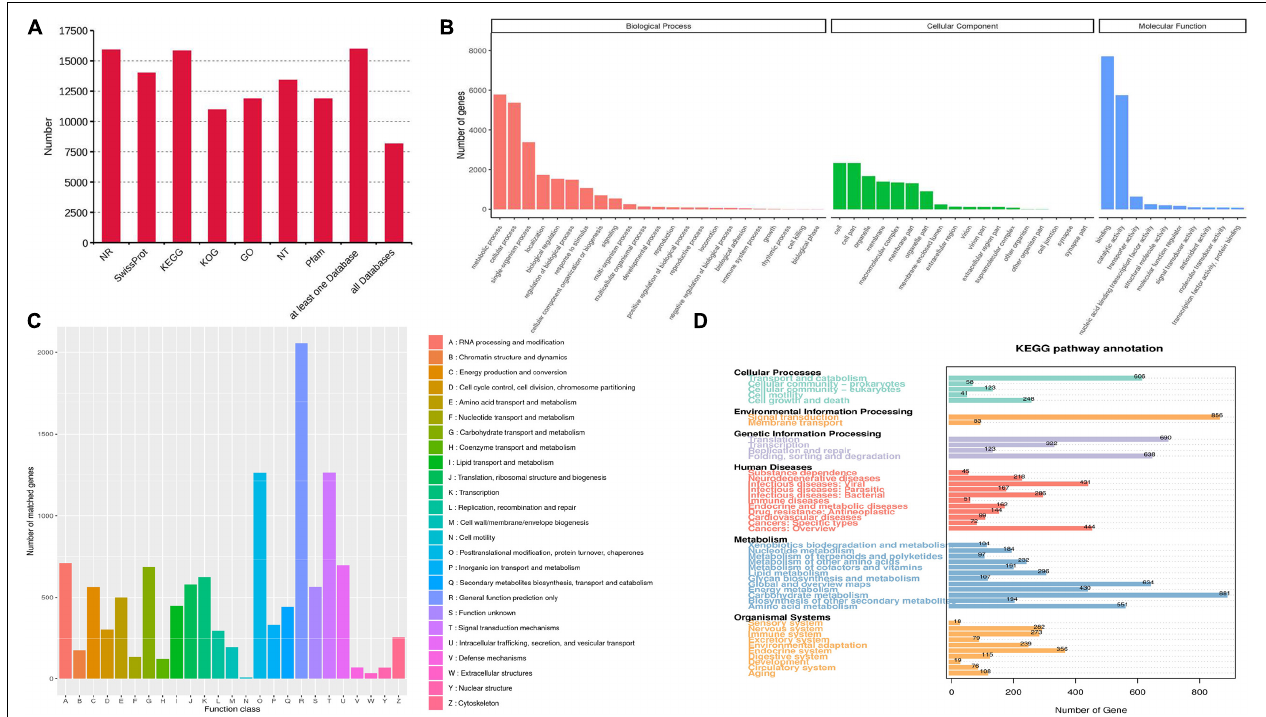
FIGURE 3 | Functional annotation and classification of transcriptomes. (A) The unigene numbers annotated in non-redundant protein sequences (Nr), NCBI nucleotide sequences (Nt), protein family (Pfam), eukaryotic/clusters of orthologous groups (KOG/COG), Swiss-Prot, Kyoto Encyclopedia of Genes and Genomes (KEGG) and Gene Ontology (GO) databases. (B–D) The pathway enrichment analysis based on GO (B) , KOG (C) , and KEGG (D)